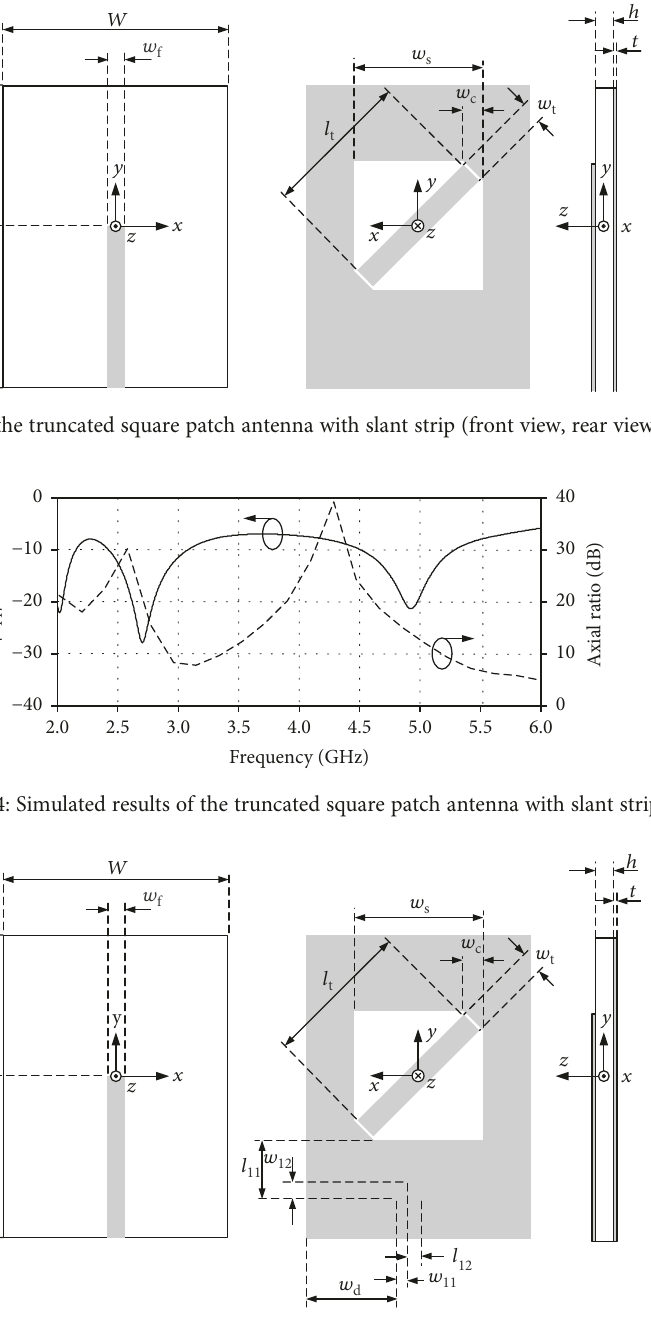
Figure 5: Structure of the truncated square aperture slot antenna with slant strip and L-shaped slot (front view, rear view, and side view).